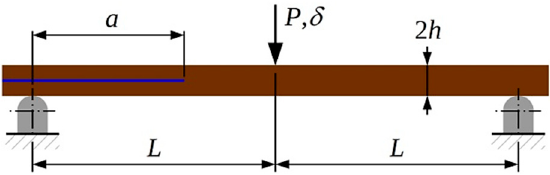
Figure 5. Schematic representation of the end-notched flexure (ENF) specimen.